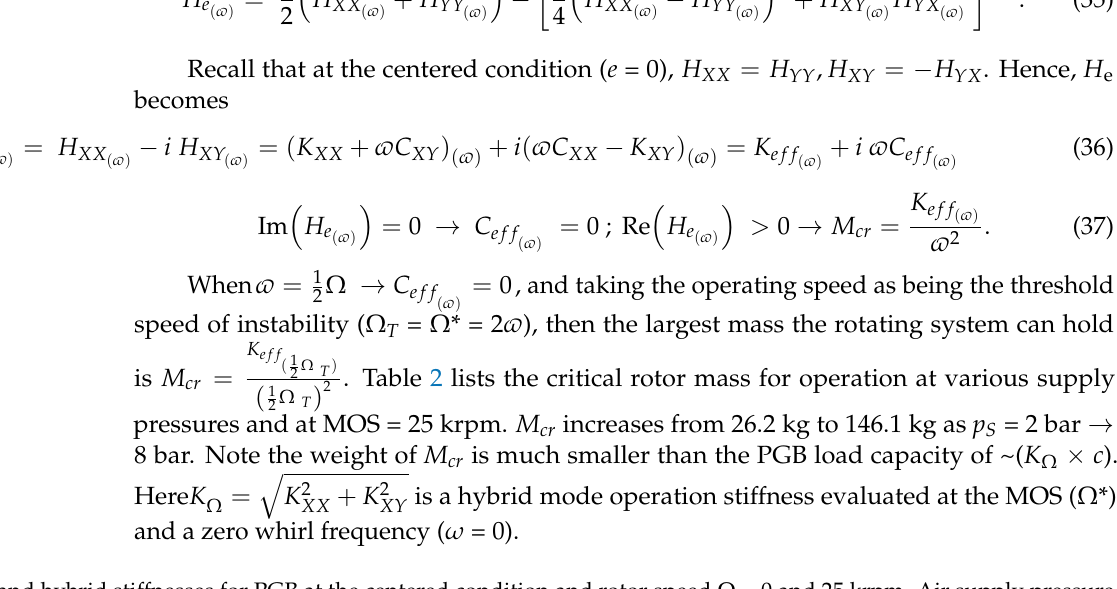
Table 2. Aerostatic and hybrid stiffnesses for PGB at the centered condition and rotor speed Ω = 0 and 25 krpm. Air supply pressure p S = 2, 4, 6, and 8 bar. Clearance c = 0.010 mm ( Λ κ =